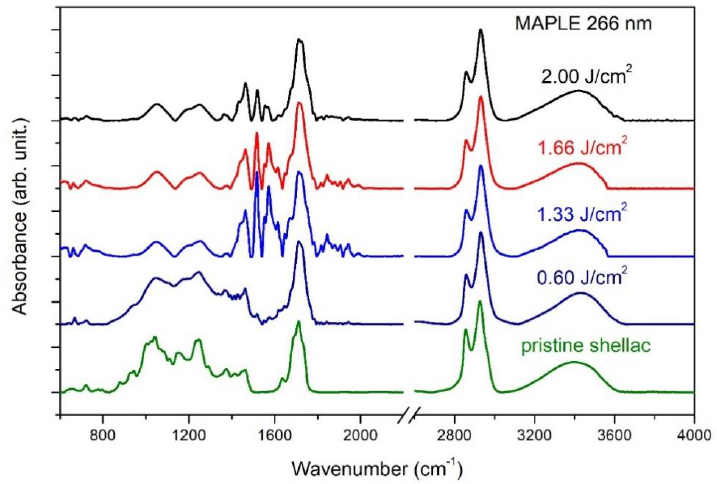
Figure 4. FTIR spectra of shellac films.